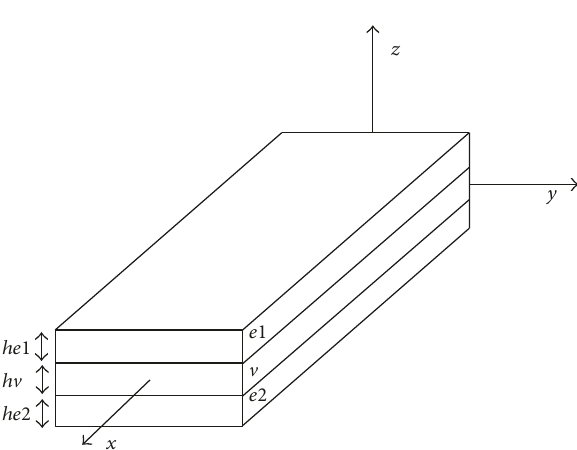
Figure 1: Schematic representation of the sandwich